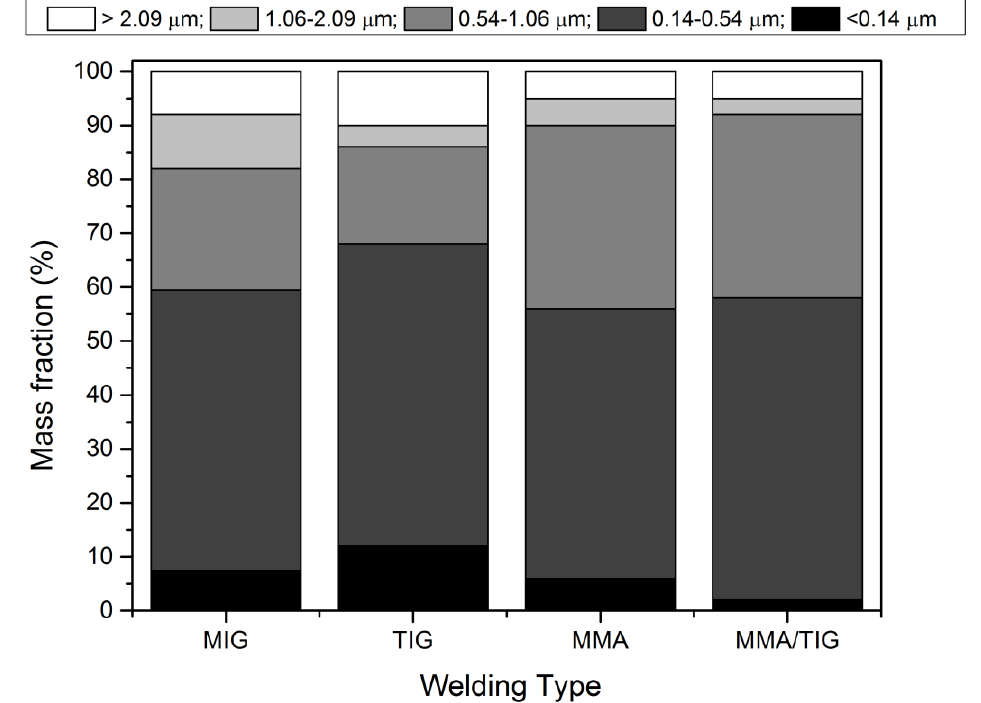
Figure 1. A representation of the possible particle size distributions of welding processes (Berlinger et al. [3]). MIG: metal arc inert gas; TIG: tungsten inert gas; MMA: manual metal arc.